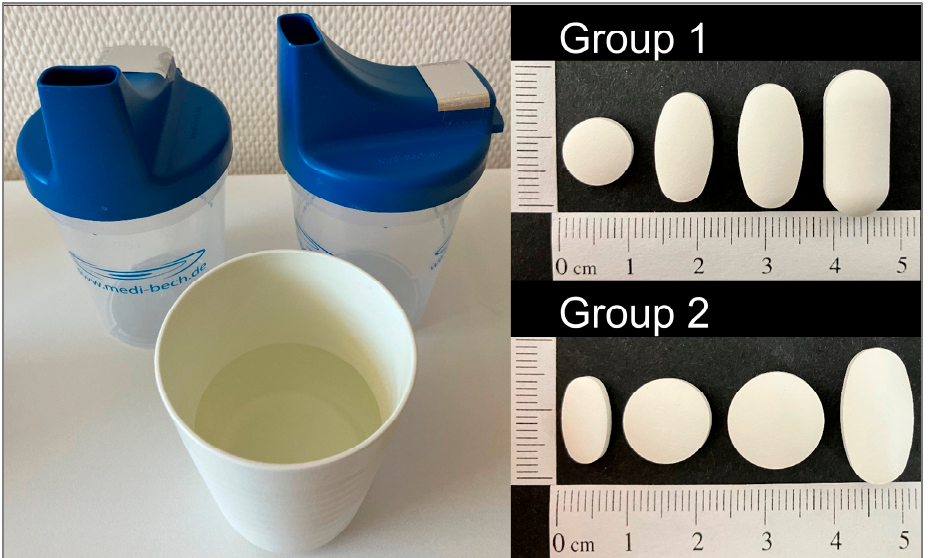
Figure 1. Medi-Bech containing one tablet at a time and cup of water provided with the four di ff erent, randomized tablets which were dependent on the group assignment.